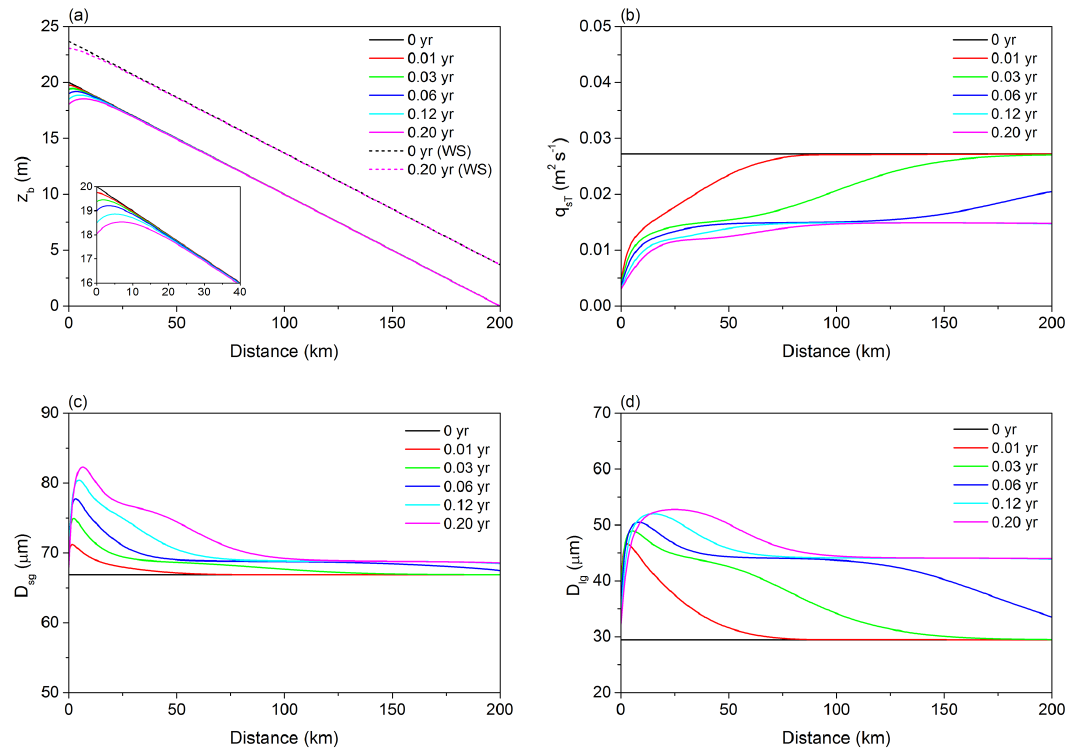
Figure 7. The 0.2-year results for the case of sediment mixtures using the entrainment form of the Exner equation: time variation of (a) bed elevation z b and water surface (WS), (b) total sediment load q sT , (c) surface geometric mean grain size D sg , and (d) geometric mean grain size of sediment load of the LYR in response to the cutoff of sediment supply. The inset shows detailed results near the upstream